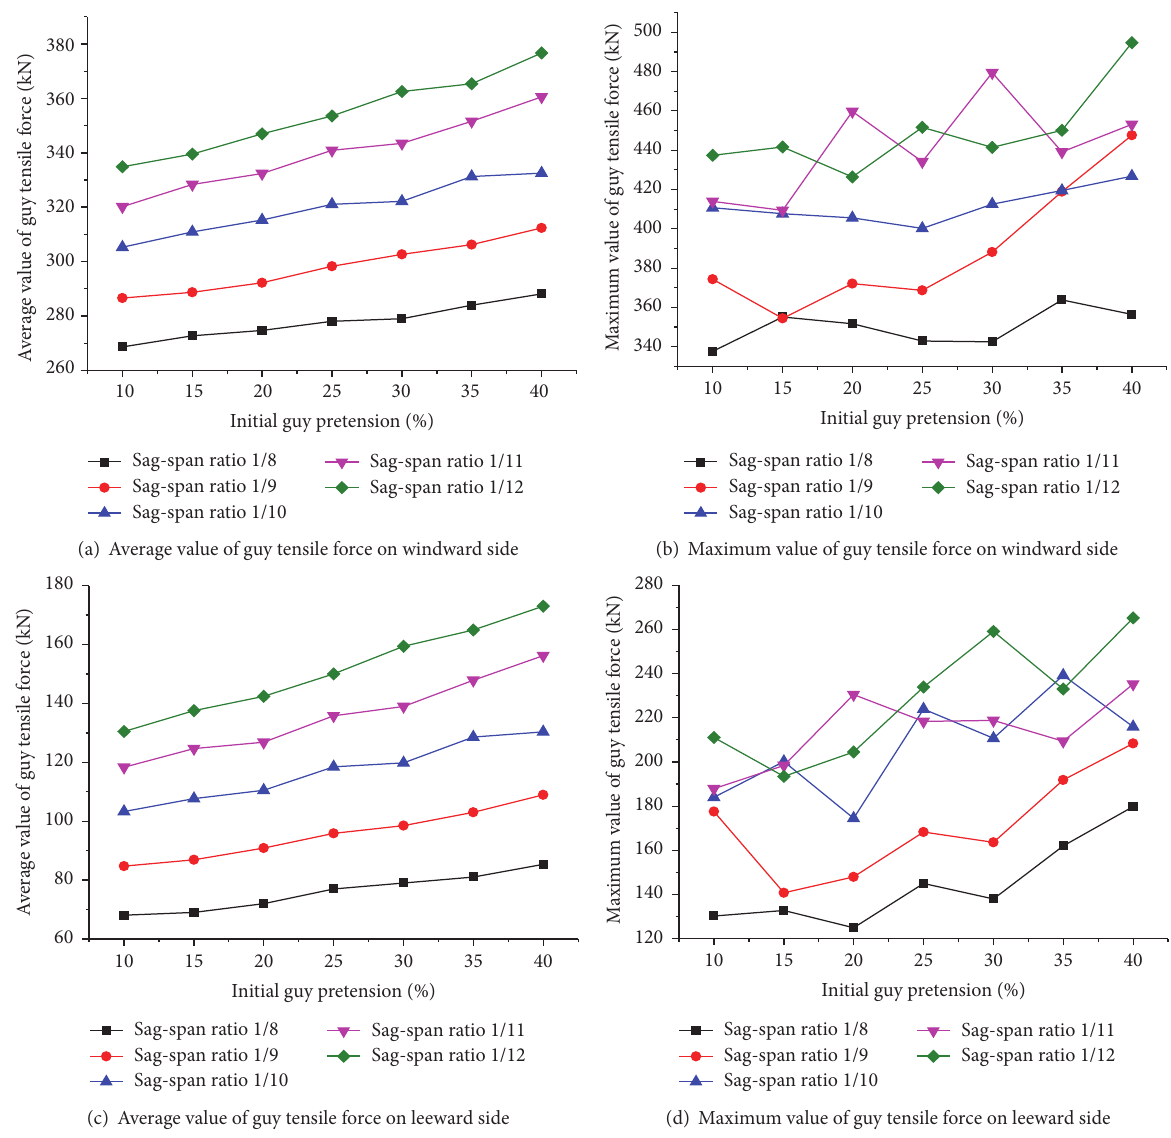
Figure 6: Effect of initial guy pretension and sag-span ratio on